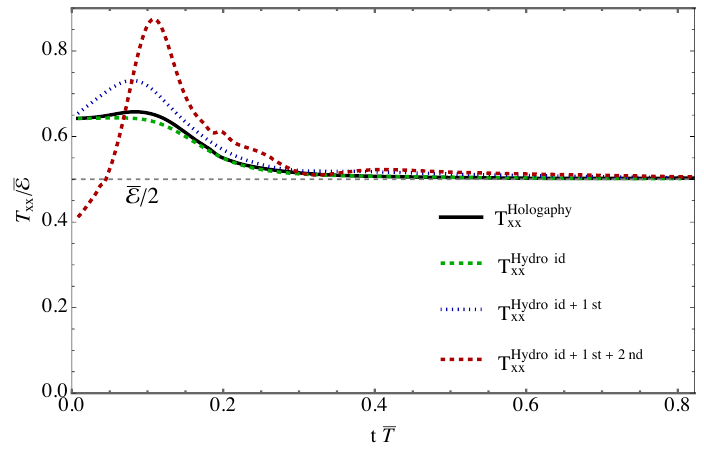
Figure 6 . Temporal component of the stress tensor conservation equation, ∂ µ T µt , at the center of the domain as a function of time.